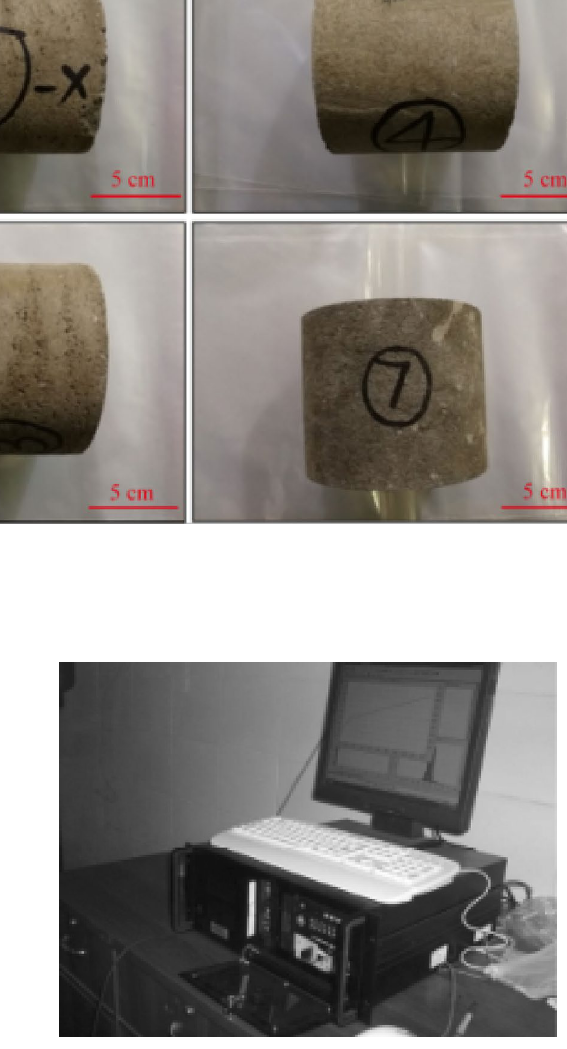
Fig. 6 Acoustic emission detection